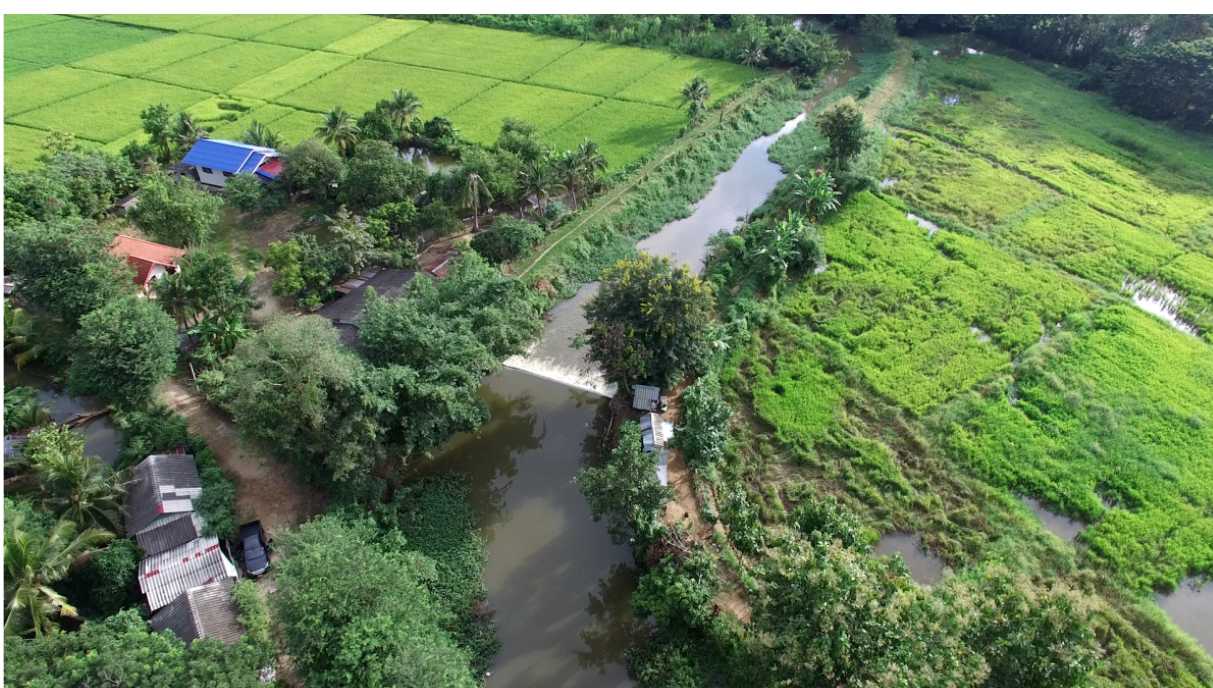
Figure 4. Muang (canal) fai (weir) on the Kuang River inside Chiang Mai’s outer ring road. The weir in the center of the image creates a retention pond at a higher level that supplies the canal on the left of the frame, which in turn gravity-feeds the rice paddies in the upper left of the frame. The cultivated rice paddies on the left are on the east side of the Kuang River within the agricultural protection zone, however the ring road is just out of the frame to the left. The unmaintained paddy on the right is within the low-density housing zone west of the river. Drone imagery Santipab Sonboom, October 2016. of land into different category according to their differ- ent functions was not formalized in a land use map in Chiang Mai until